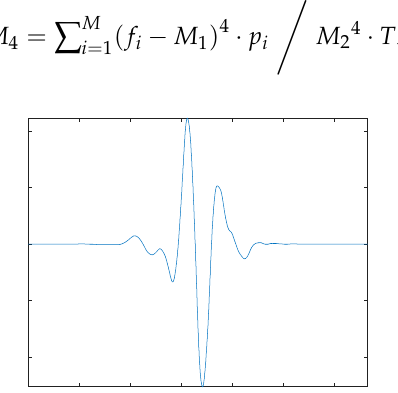
Figure 4. The seventh “symlet” wavelet function.